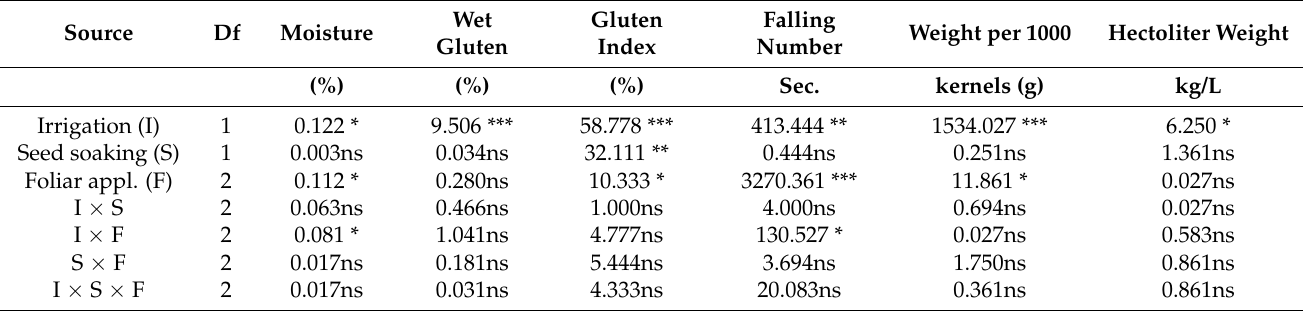
Table 8. Analysis of variance (mean square) of physical and chemical properties of grains.